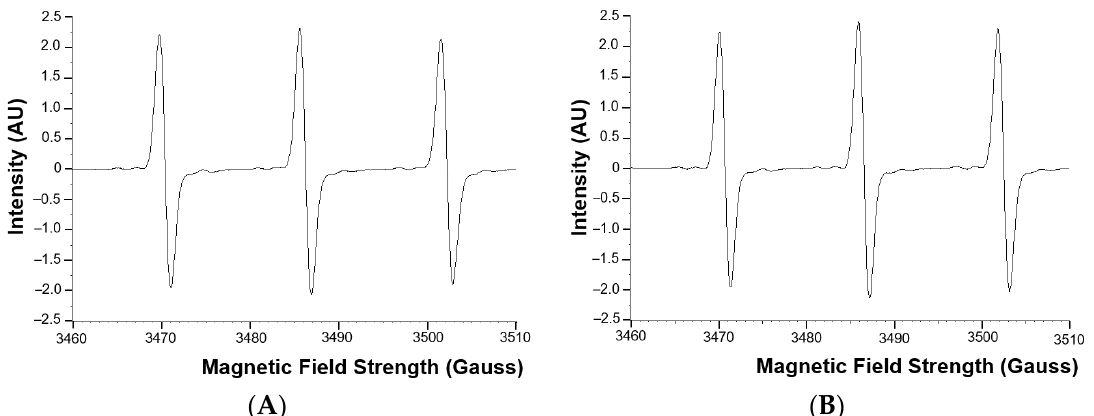
Figure 2. Examples of EPR spectra of the CMH radical detected in whole blood of a typical patient ( A ) and matched healthy control ( B ). AU = arbitrary units.